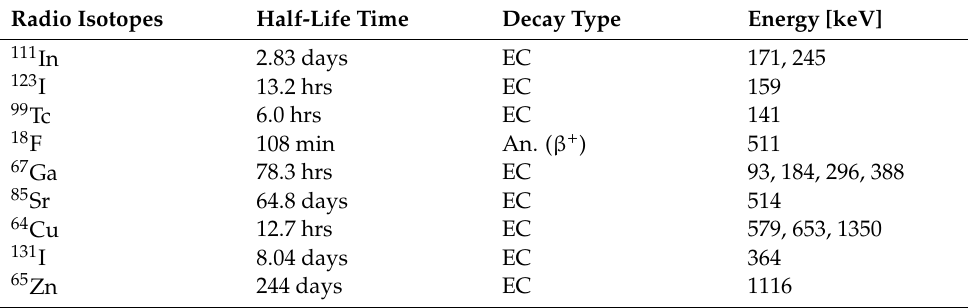
Table 4. Commonly used RI tracers in nuclear medicine with their properties. Radio Isotopes Half-Life